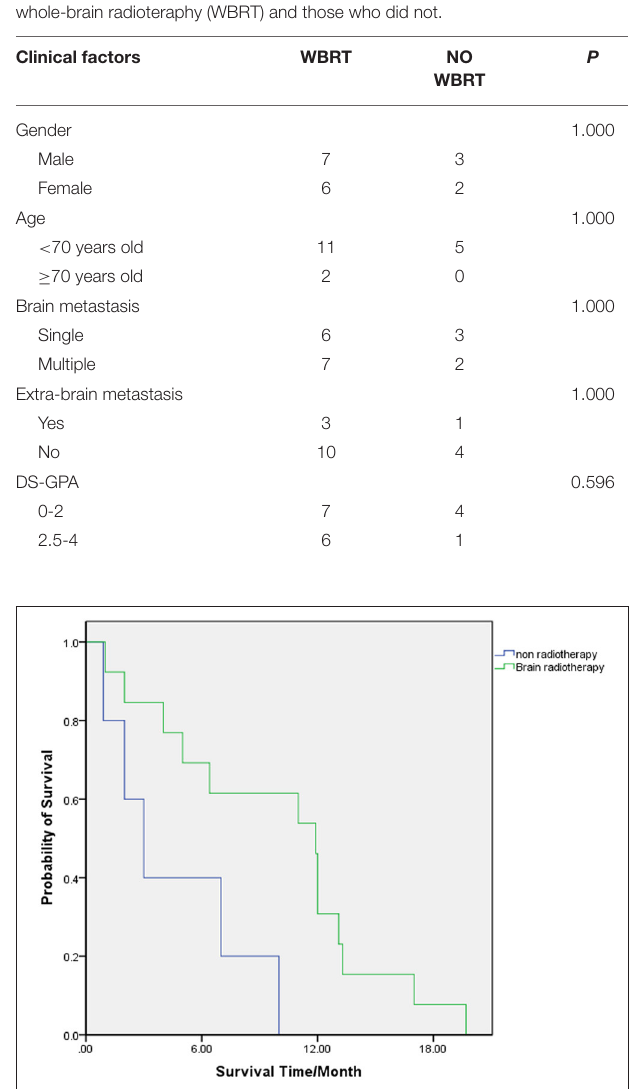
FIGURE 2 | OS for patients who received WBRT (Green) and for who did not